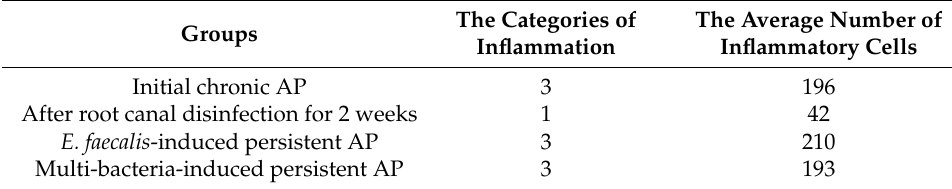
Table 1. The histopathologic results in each time